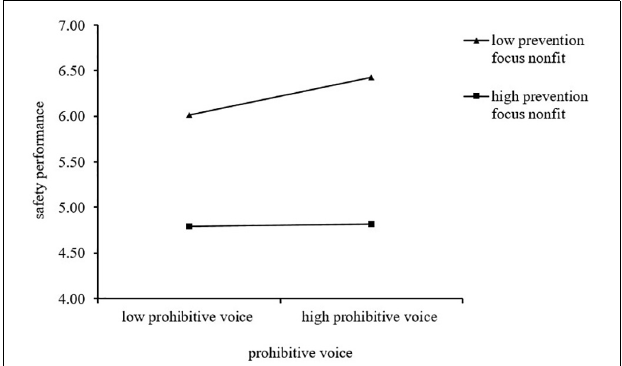
FIGURE 2 | The interactive effect of the prohibitive voice and prevention focus fit on safety